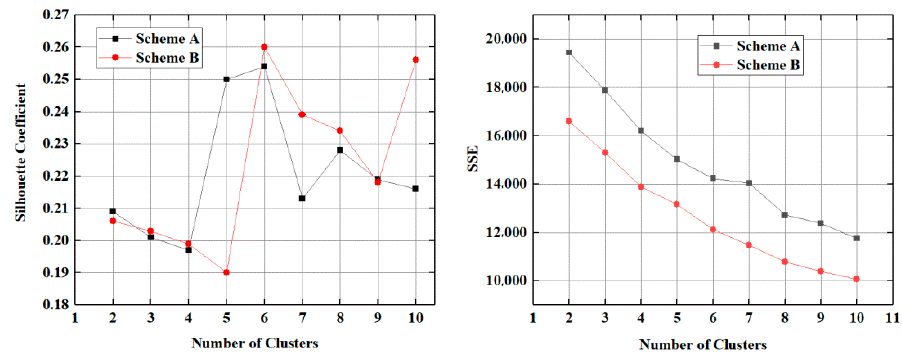
Figure 3. Average silhouette coefficient and sum of squared error (SSE) versus number of clusters for Scheme A and B.